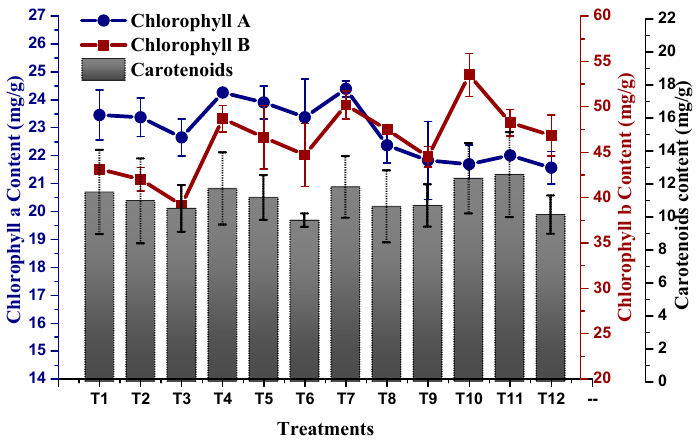
Figure 7. Effect of TU–ANPs on photosynthetic contents (chlorophyll a, b and carotenoids) of Zea mays under various levels of NaCl-based osmotic stress.